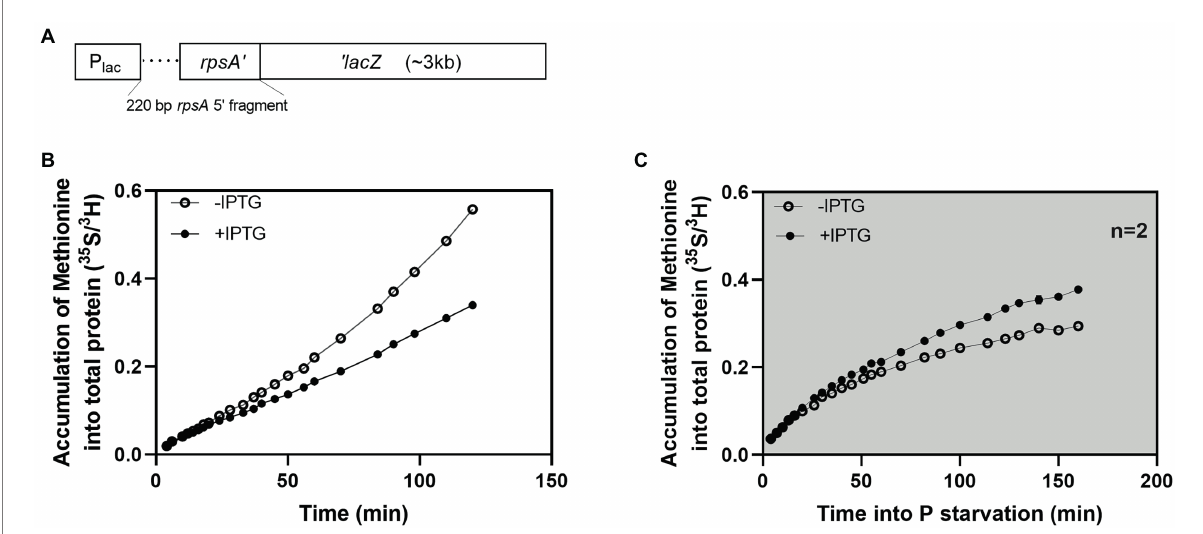
FIGURE 2 Induction of a long-lived hybrid mRNA led to an increased protein synthesis rate during P starvation. Effects of induction of a long-lived hybrid mRNA on protein synthesis under balanced growth and P starvation in E. coli strain MAS1143 ( lacI q1 lacZ ::Tn 5 ). (A) Schematic showing the rpsA’ - ‘ lacZ hybrid gene construct (not to scale). (B) Accumulation of 35 S-methionine in protein during balanced growth (open circles) and after induction of the rpsA’ -‘ lacZ mRNA with IPTG (closed circles) in E. coli strain MAS1143/pIV18. The ratio of 35 S/ 3 H counts is presented over time. At time “0”, 35 S-methionine was added to a culture in balanced growth that was pre-labeled with 3 H-lysine. The culture was divided into two flasks, and IPTG was added to one of them at time +9 min. The data in panel B is representative of two independent biological replicates. The replicate experiment is shown in Supplementary Figure S2. (C) Accumulation of 35 S-methionine in protein during P starvation, with (closed circles) or without (open circles) induction of rpsA’-‘lacZ transcription with IPTG in E. coli strain MAS1143/pIV18. Procedure as described for panel B, except that cells were transferred to P-free medium by filtration at time − 2 min. The data in panel C corresponds to the average of two biological replicates, and the error bars (smaller than plotting symbols) indicate the SEM. The cultures used in panel B and C were grown in MOPS minimal medium supplemented with 0.4% glycerol and 100 μ g/ml ampicillin. The average doubling time during balanced growth was 100